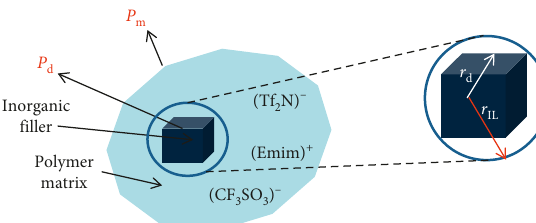
Inorganic filler Polymer matrix Figure 5: Schematic representation of ionic liquid mixed matrix